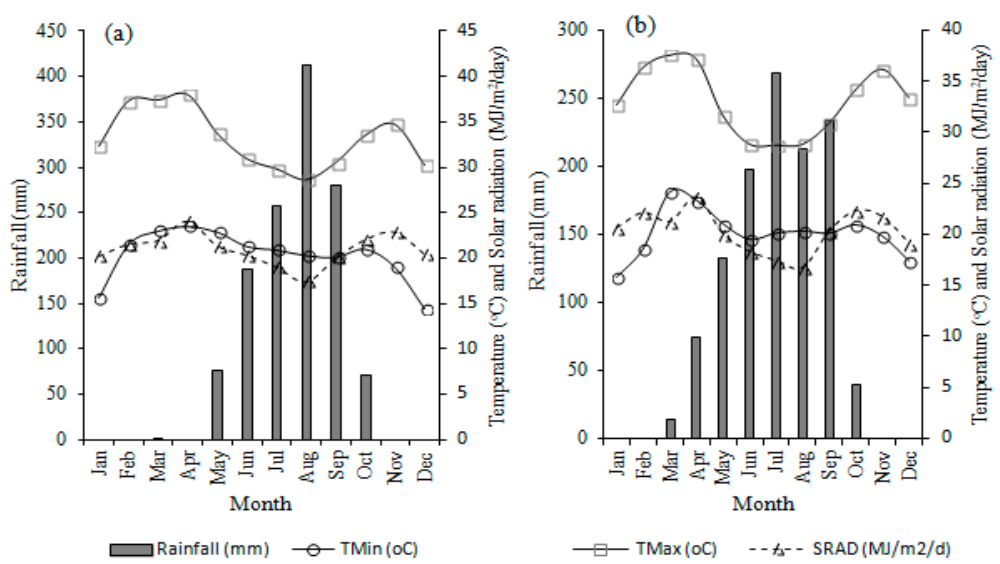
Figure 1. Monthly rainfall, temperature and solar radiation at Iburu for 2015 ( a ) and 2016 ( b ) experimental year.